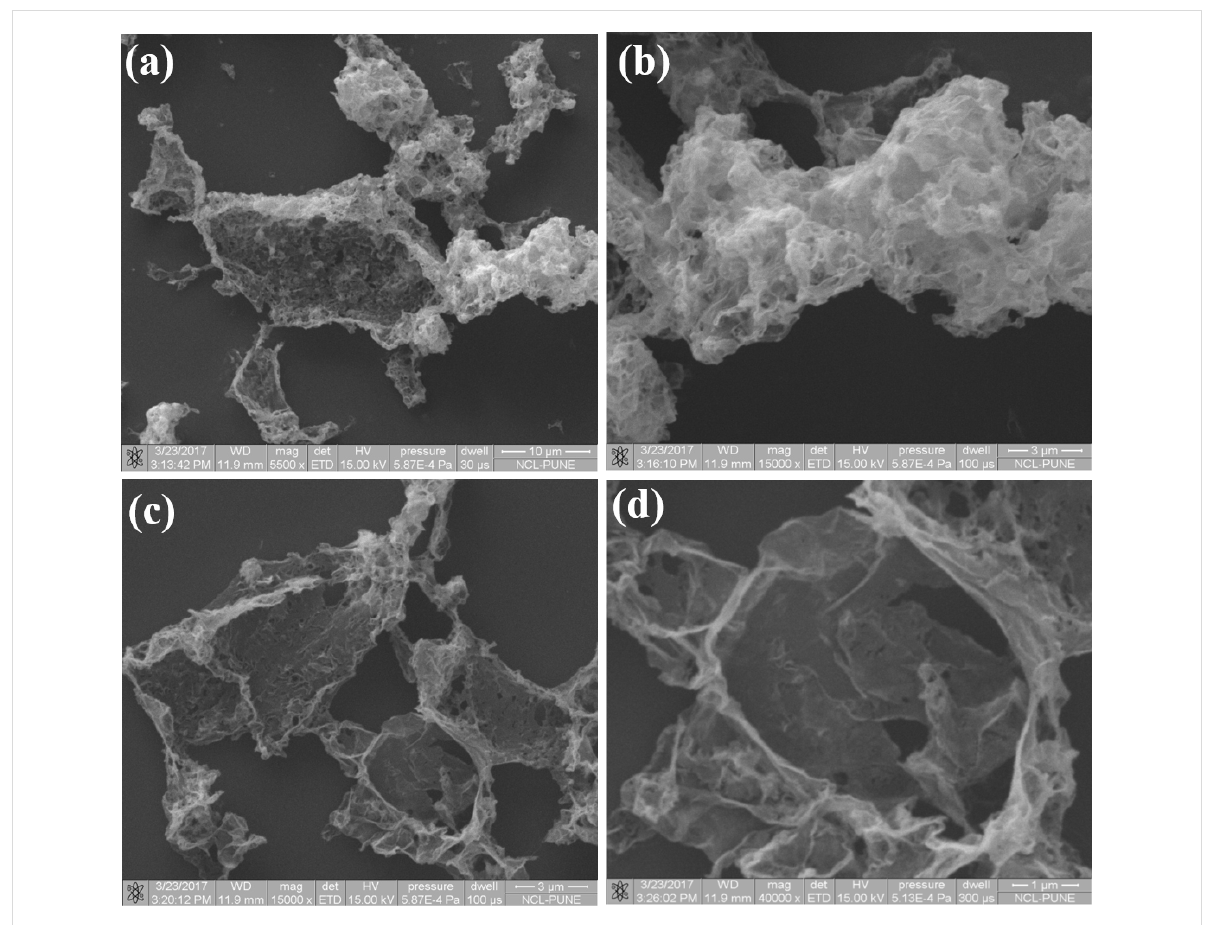
Figure 2: (a–d) Typical SEM images for PtSe 2 nanosheets synthesized using the wet chemistry method.